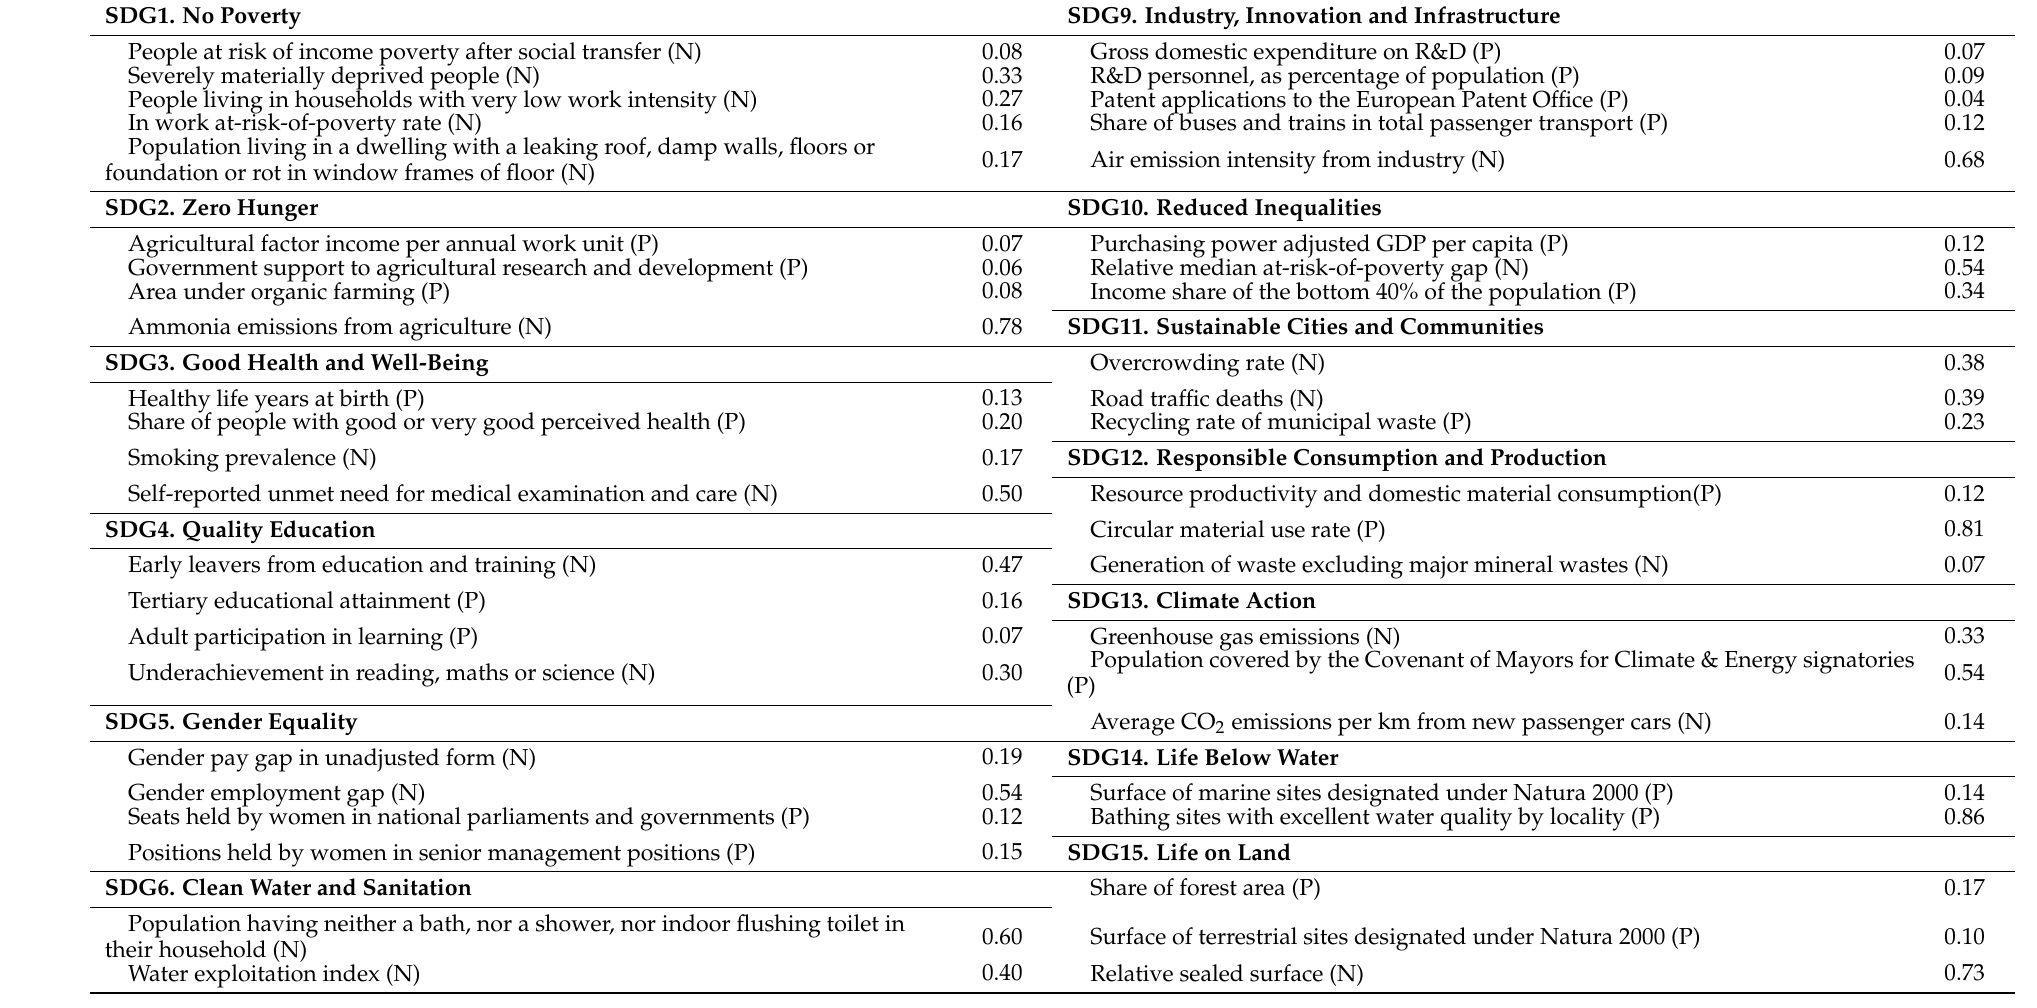
Table 1. Indicators list, with direction of change in parenthesis, and aggregation